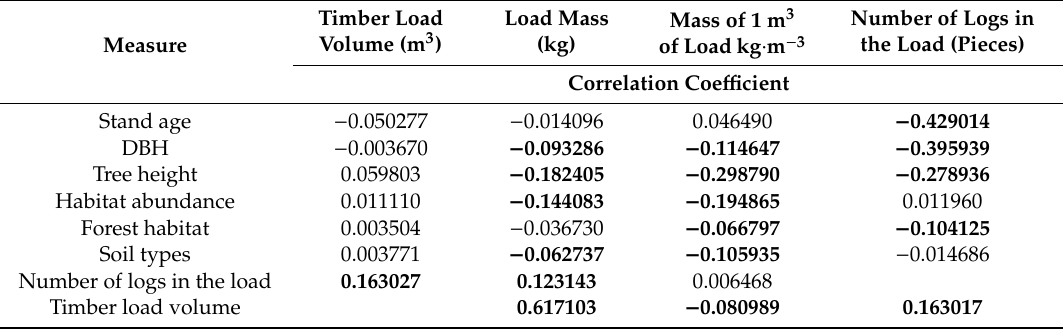
Table 4. Spearman’s rank correlation coe ffi cient for load parameters depending on the wood origin parameters.